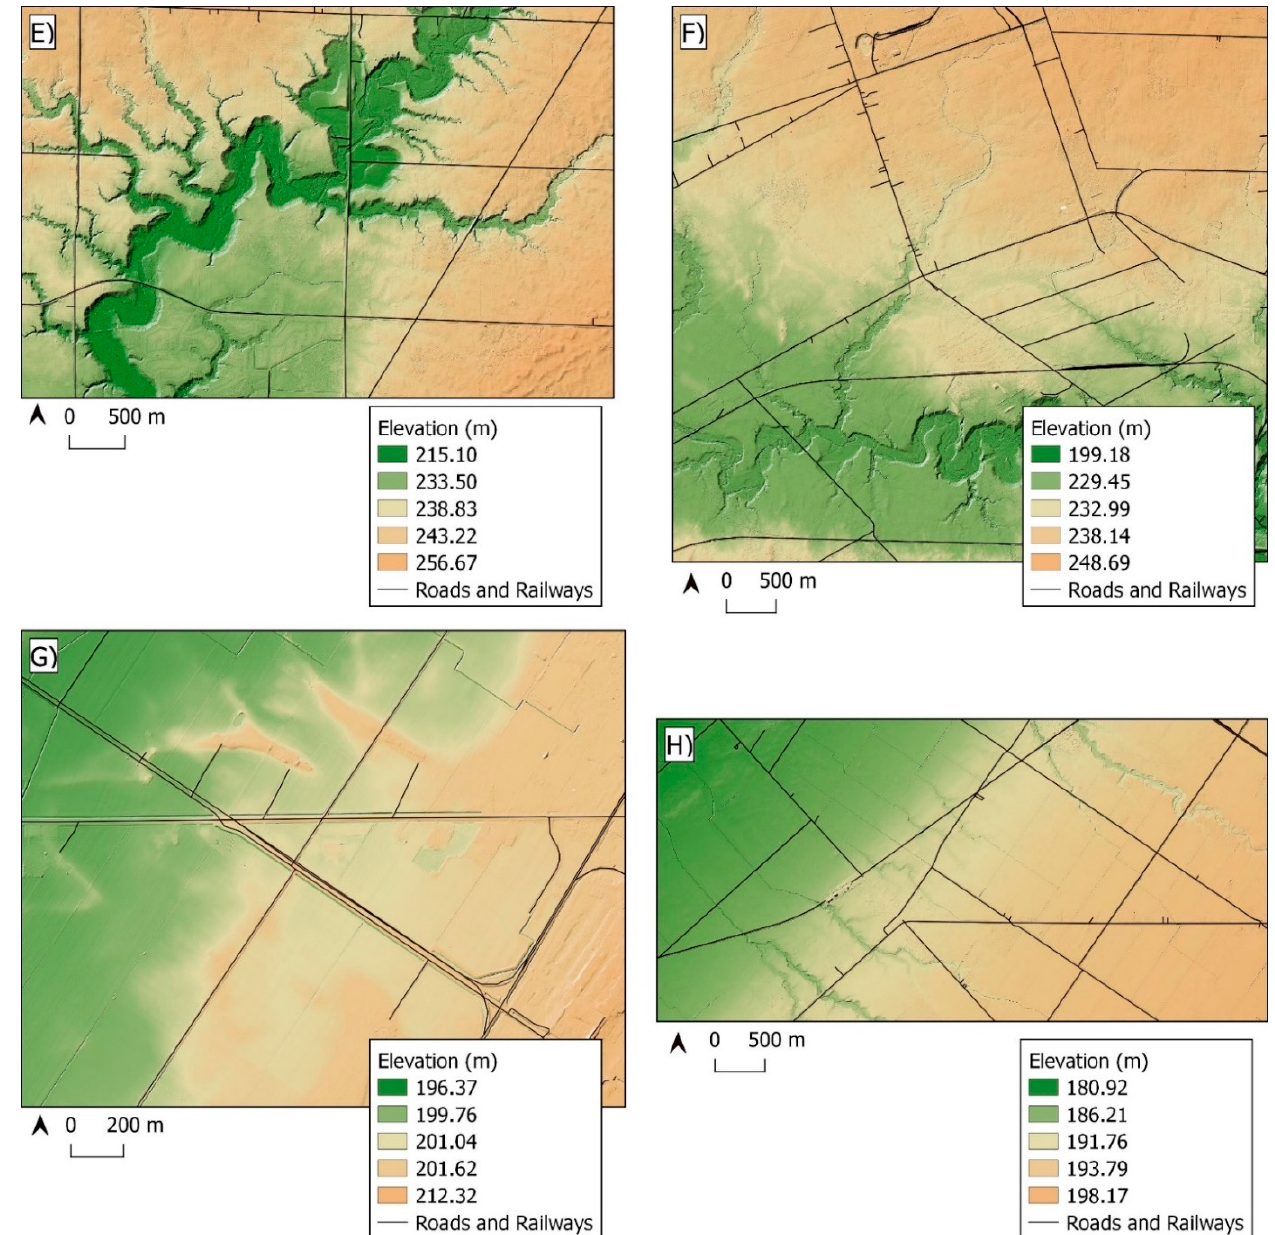
Figure 3. Four of the eight study sites across southwestern Ontario, Canada. ( A ) The Catfish Creek 1 site; ( B ) The Catfish Creek 2 site; ( C ) the Brantford 1 site; ( D ) The Brantford 2 site. ( E ) The Kettle Creek 1 site; ( F ) The Kettle Creek 2 site; ( G ) the McGregor Creek 1 site; ( H ) The McGregor Creek 2 site. Only roads or railways on embankments have been included. Table 2. Characteristics of the study site DEMs. Relief is the difference between the highest and lowest elevation in a dataset. Road/rail length refers to the total length of the edited transportation network vector, including all roads and railways on embankments.